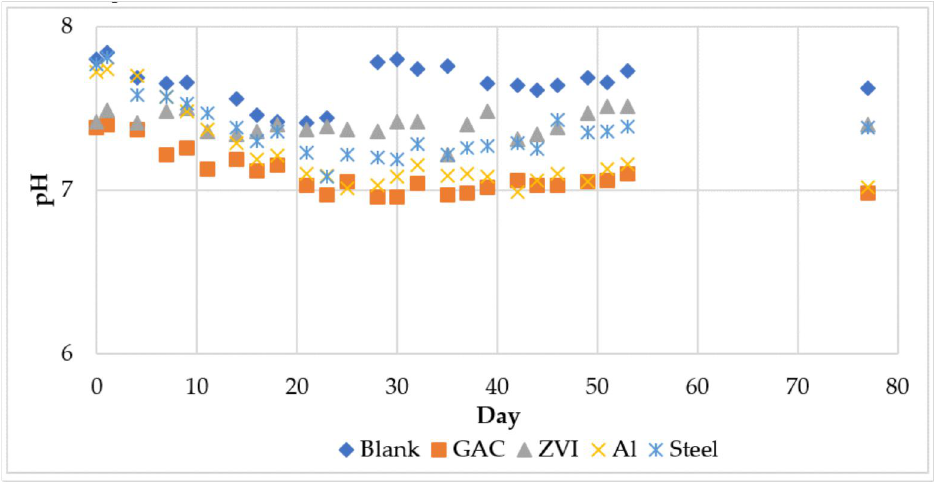
Figure 5. Measured pH in semi-continuous tests.